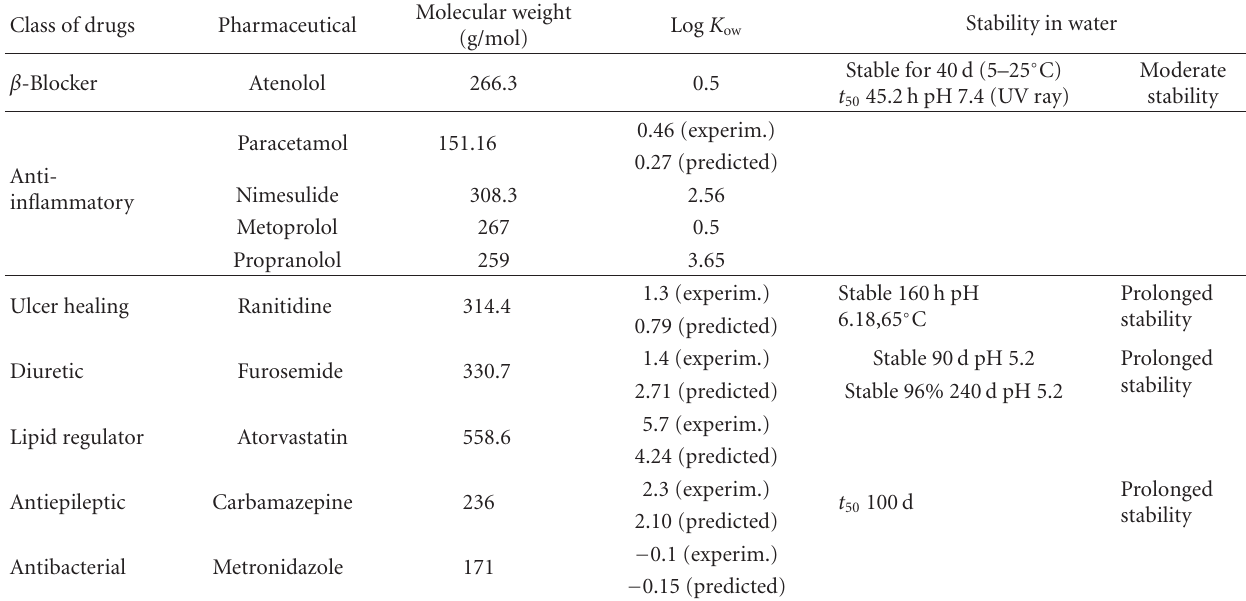
Table 1: Literature values (S. Castiglioni et al., 2004; R. Andreozzi et al., 2003; Banca dati Farmacoambiente; Drugbank) of the physico- chemical properties and degradation behaviour of the selected